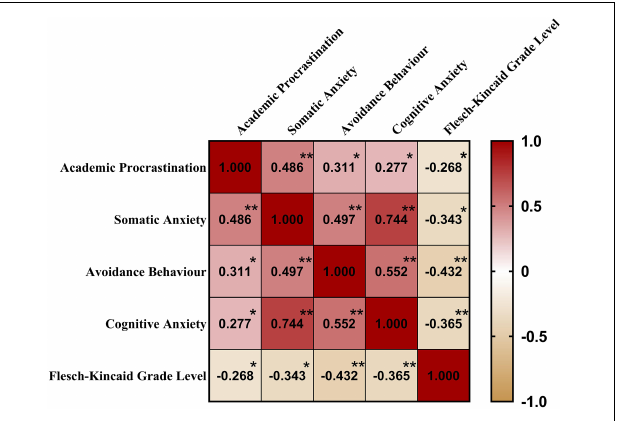
FIGURE 3 | Heat map: correlations among academic procrastination, L2 writing anxiety and Flesch-Kincaid Grade Level. Values in the map are correlation coefficients; * Sig < 0.05; ** Sig <